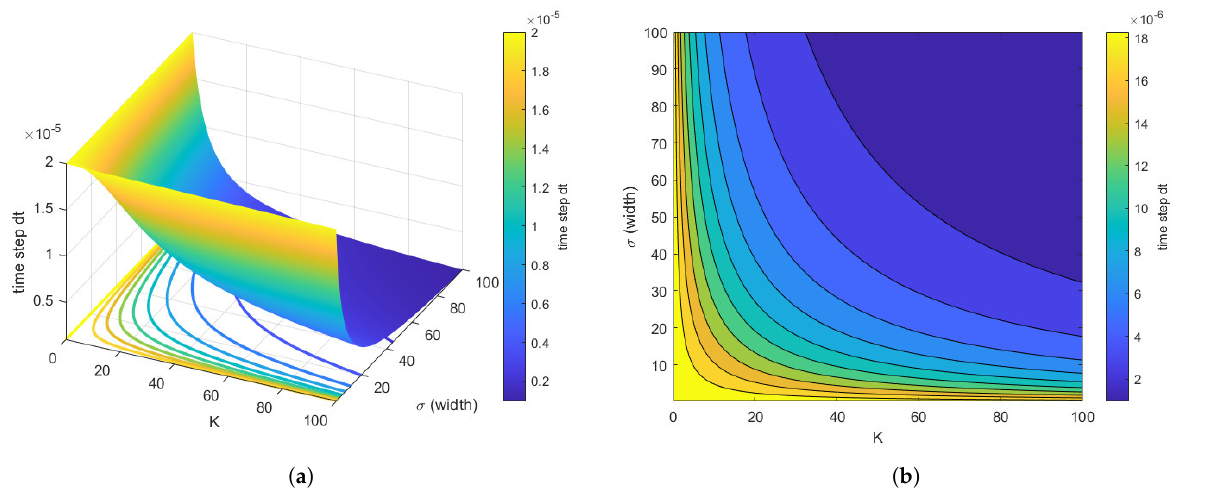
Figure 4. Time step restriction (61) and D = 5 for different K and channel width σ = b either K or the channel width σ